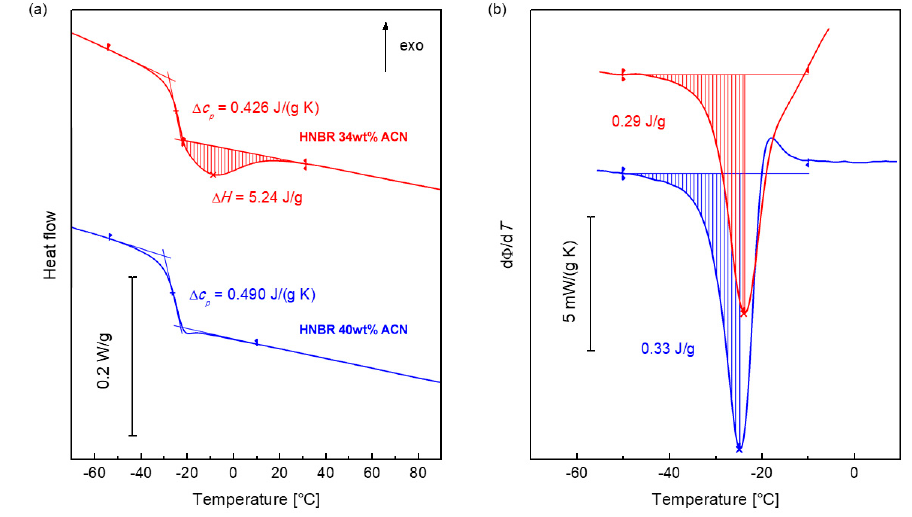
Figure A1. ( a ) DSC heating curves of HNBR with 34 wt % and 40 wt % ACN. ( b ) The first derivatives Figure A1. (a) DSC heating curves of HNBR with 34 wt % and 40 wt % ACN. (b) The first derivatives of the DSC curves in the glass transition of the DSC curves in the glass transition range.